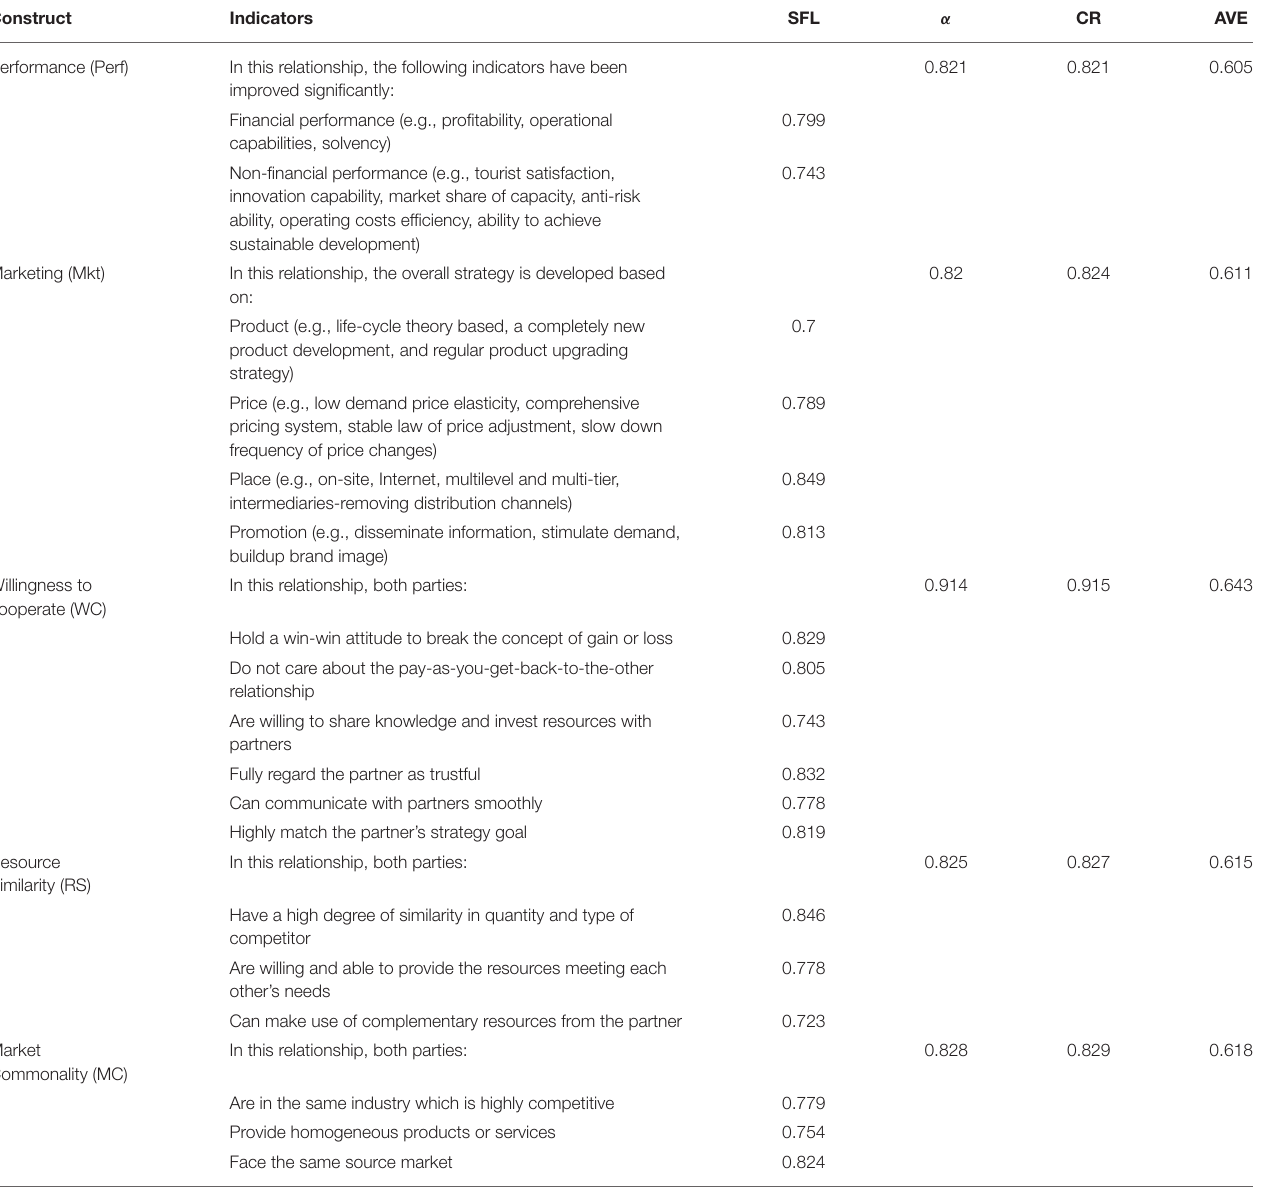
TABLE 3 | Constructs, indicators, and reliability.